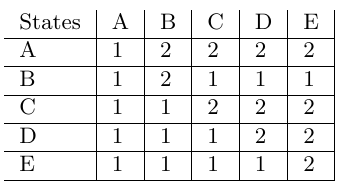
Table 4: The resulting optimal actions found after ex- ploring the graph world depicted in Figure